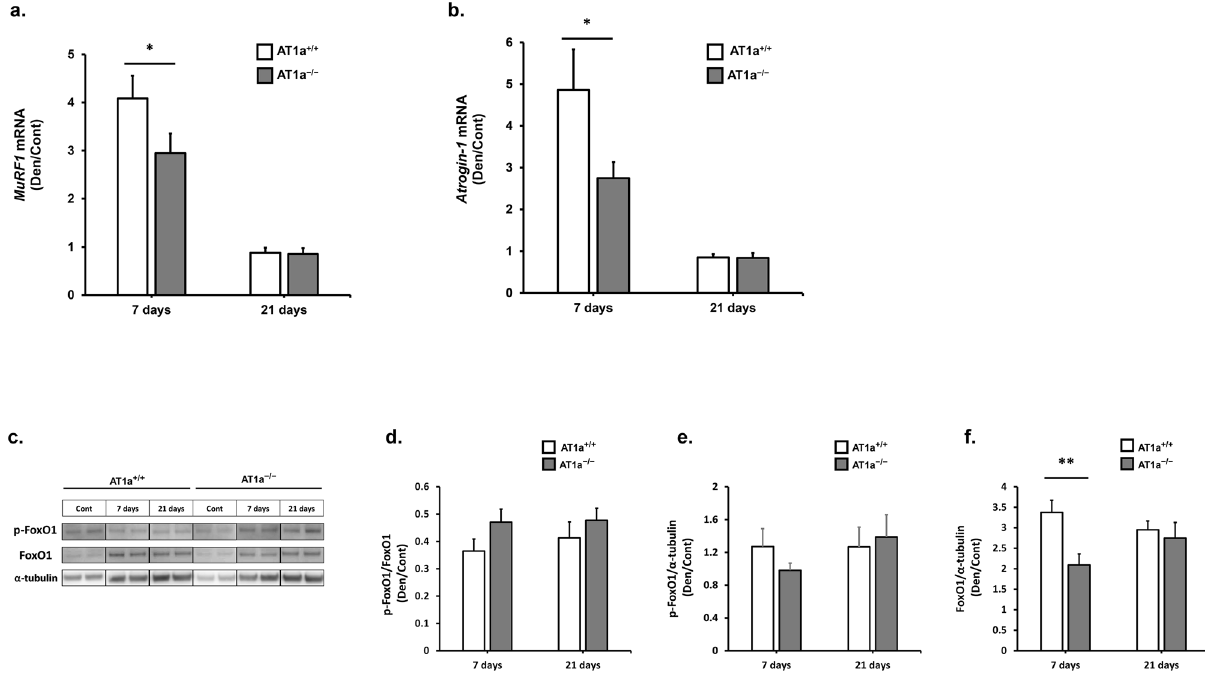
Figure 2. AT1a receptor loss reduced the gene expressions related to protein degradation system through downregulation of FoxO1 expression in the denervated gastrocnemius muscle. ( a , b ) Gene expressions of MuRF1 ( a ) and Atrogin‑1 ( b ) were evaluated by RT-qPCR. Expression levels of these transcripts in each sample were normalized to 18S rRNA expression levels and were shown as the fold increase or decrease in mRNA expression in the Den group compared with the Cont group. ( c–f ) Protein expression levels of phosphorylated FoxO1 and total FoxO1 were evaluated by western blot analysis. Expression levels in each sample were normalized to α-tubulin expression levels and were shown as the fold increase or decrease in the protein expression in the Den group compared with the Cont group. Relative protein expression was calculated for p-FoxO1/FoxO1 ( d ), p-FoxO1/α-tubulin ( e ), FoxO1/α-tubulin ( f ). Samples from the same experiment were processed in parallel for SDS-PAGE and western blotting using different gels and membranes, and the image data obtained were cropped. Entire images of western blotting are shown in online supplementary resource Supplementary Fig. S5. AT1a +/+ -Cont group, n = 6; AT1a +/+ -Den group at 7 days postdenervation, n = 7; AT1a +/+ -Den group at 21 days postdenervation, n = 7; AT1a −/− -Cont group, n = 5; AT1a −/− -Den group at 7 days postdenervation, n = 6; AT1a −/− -Den group at 21 days postdenervation,n = 6. Values are means ± SE. * P < 0.05, ** P <